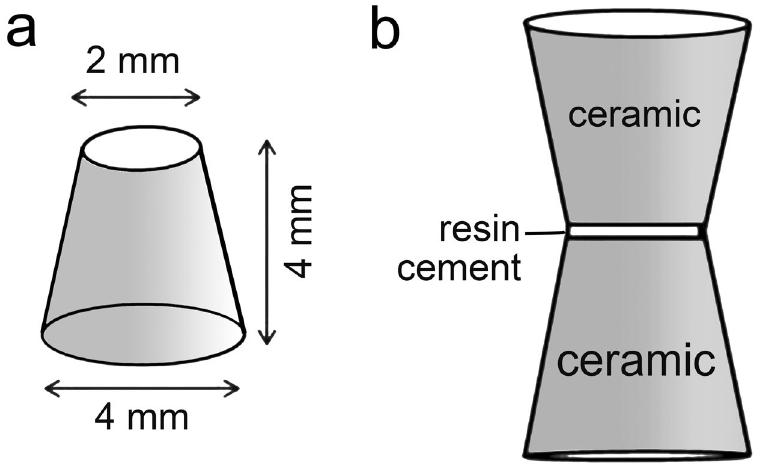
Figure 1. Specimen dimensions. ( a) Lithium disilicate truncated cone. ( b ) Hourglass-shaped